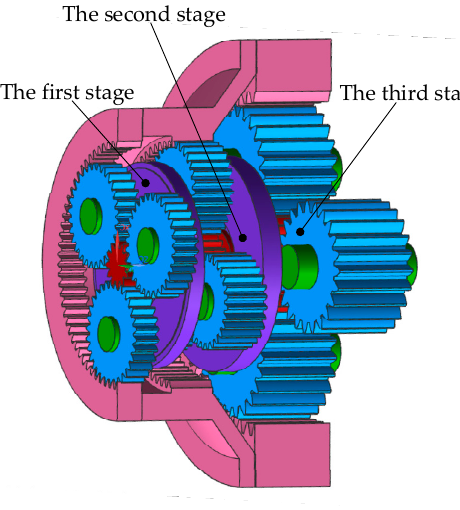
Figure 1. The three dimension structure.